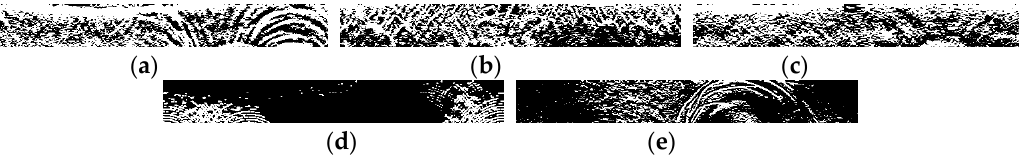
Figure 13. Example of salient images with and without an iris image. ( a ) Salient image of Figure 2b, ( b ) salient image of Figure 2d, ( c ) salient image of Figure 2f, ( d ) example of eyeless highlight image, ( e ) example of salient image with incorrect pupil delineation.